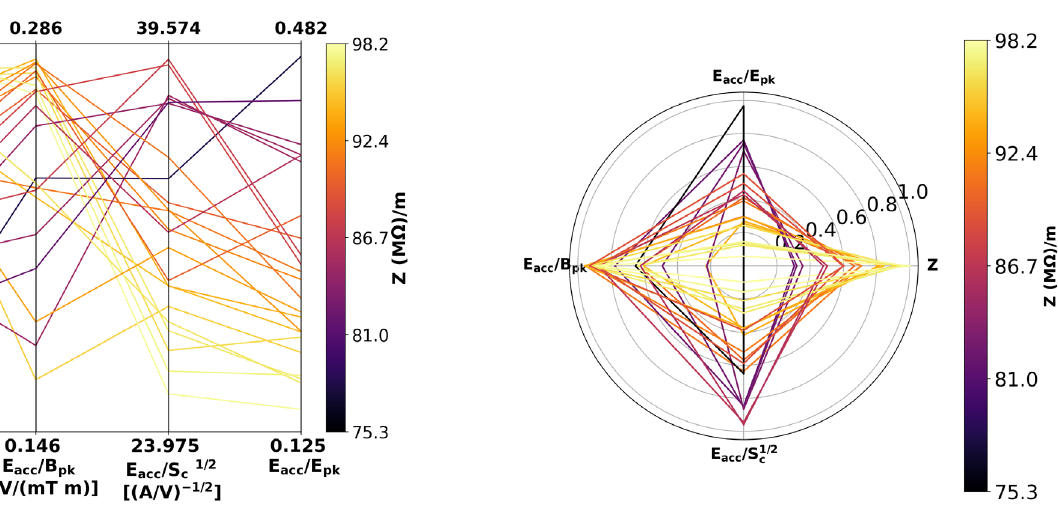
FIG. 20. Refined RC showing four objectives for the C-band SW single cell with 20 clustered